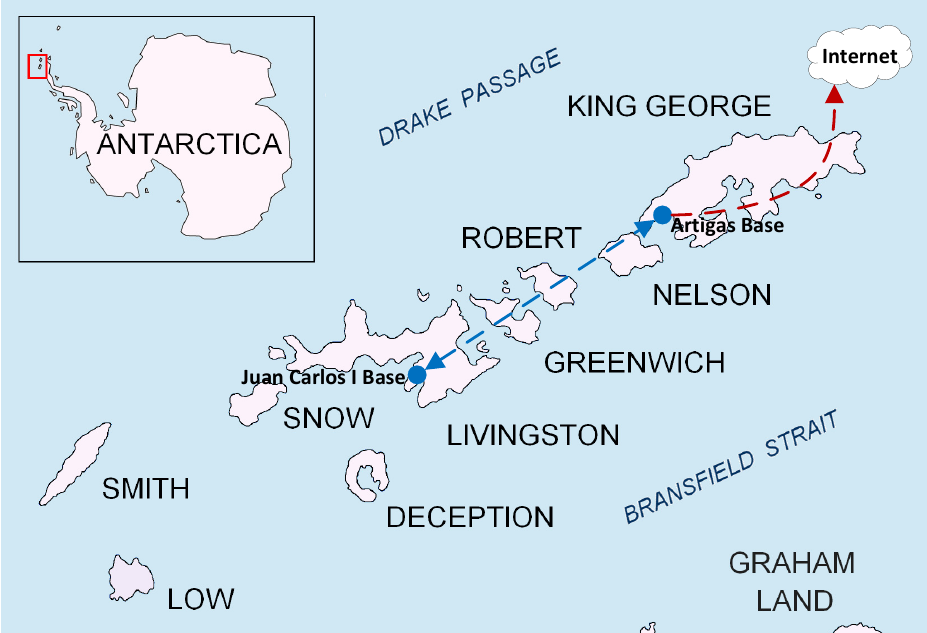
Figure 1. Map of the South Shetland Islands in Antarctica [10], showing the position of the WSNs (blue circles) during the test scenario of the campaign. The NVIS link is represented with the discontinuous blue line, and the Internet connectivity is represented with the discontinuous red line. The reproduction of the image was slightly modified under a Creative Commons License (CC BY-SA 3.0).